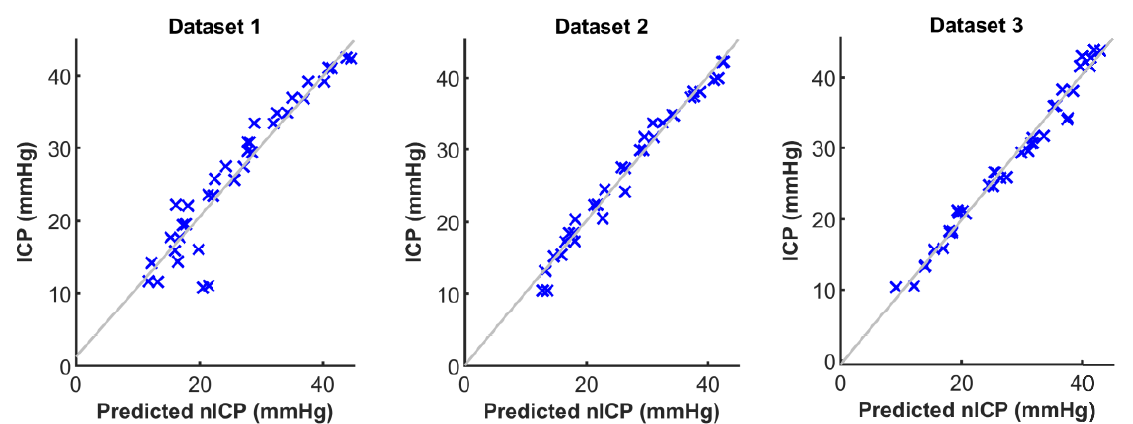
Figure 6. Scatter plots between predicted non-invasive intracranial pressure (nICP) and the refer- ence invasive ICP